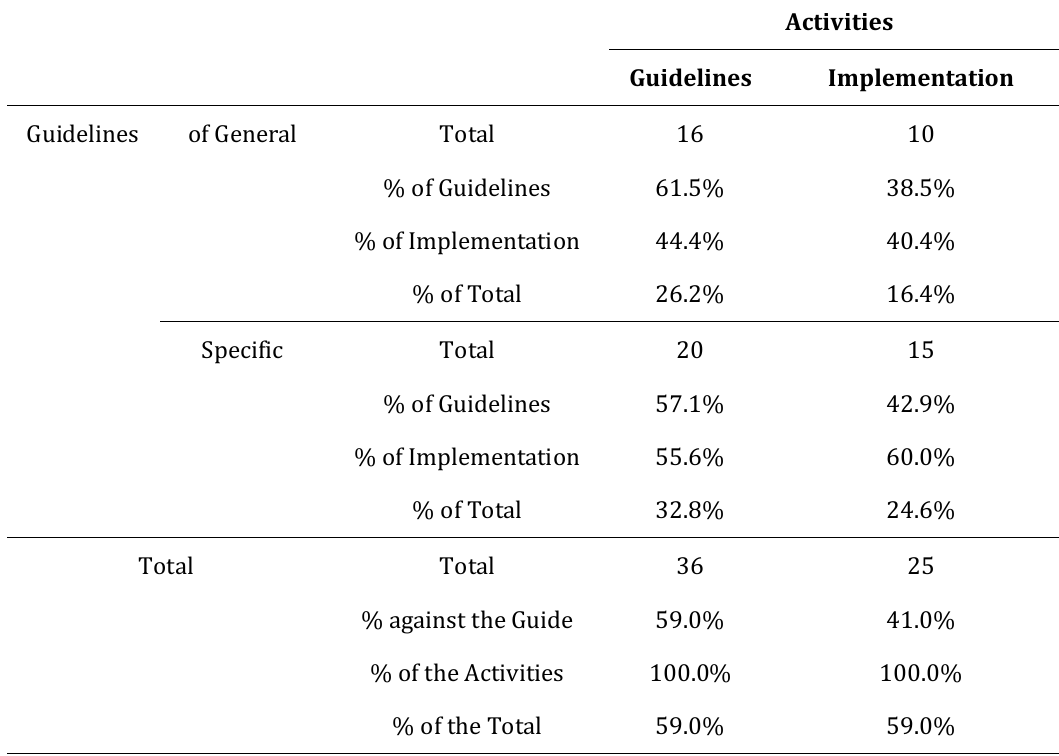
Table 2 The results crosstabulation of the CHSE implementation on the Payung Rafting tourism